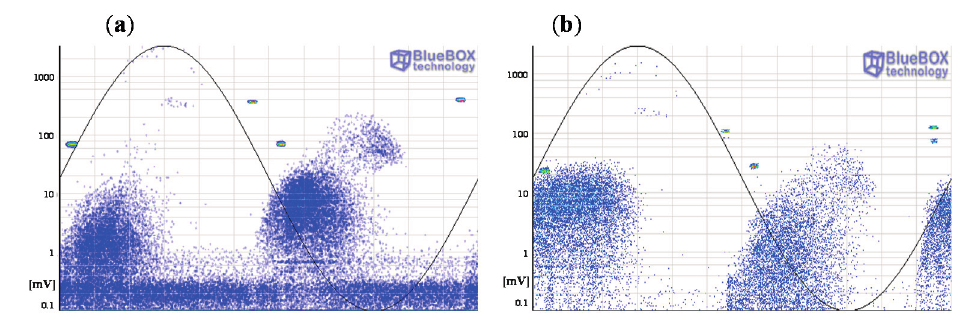
Figure 19. PRPD patterns obtained with the HFCT sensors. ( a ) HFCT 1 in position C; ( b ) HFCT 2 in position E.